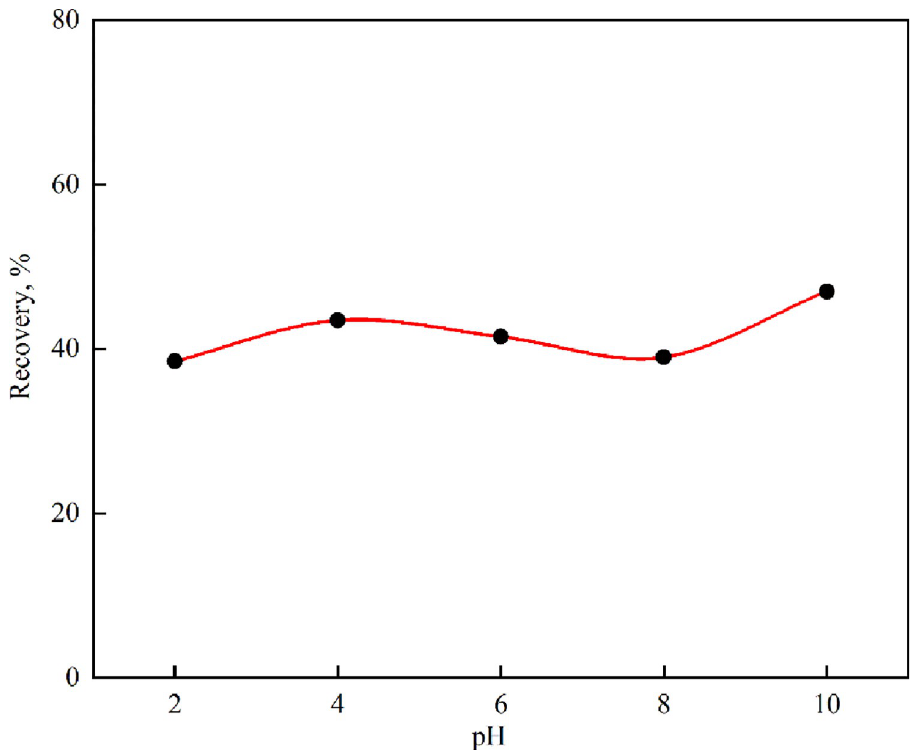
Fig 2. Effect of pH on flotation recovery of coal with E . coli at concentration of 5 × 10 9 cells/ml.